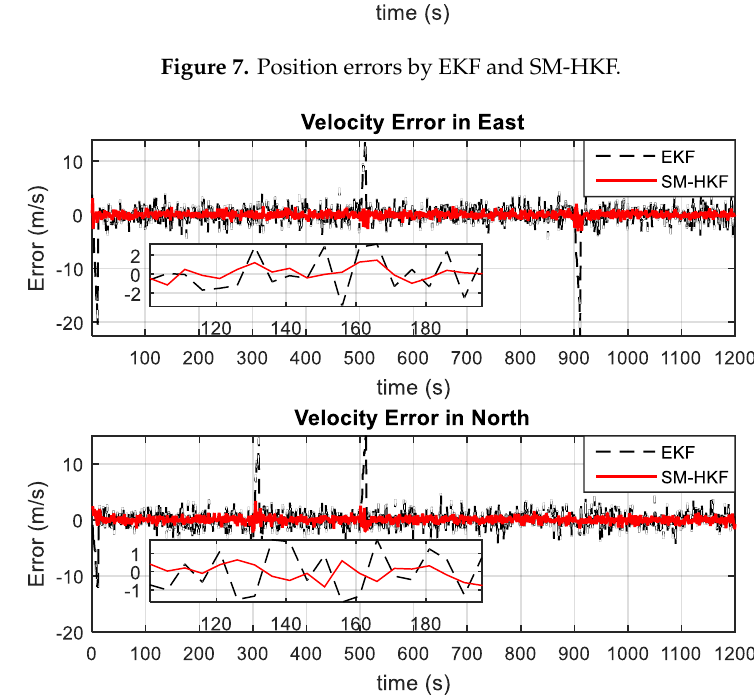
Figure 8. Velocity errors by EKF and SM-HKF. Table 2. The means of the RMSEs of estimation errors obtained by EKF and SM-HKF during the time segment with unknown but bounded (UBB) errors.